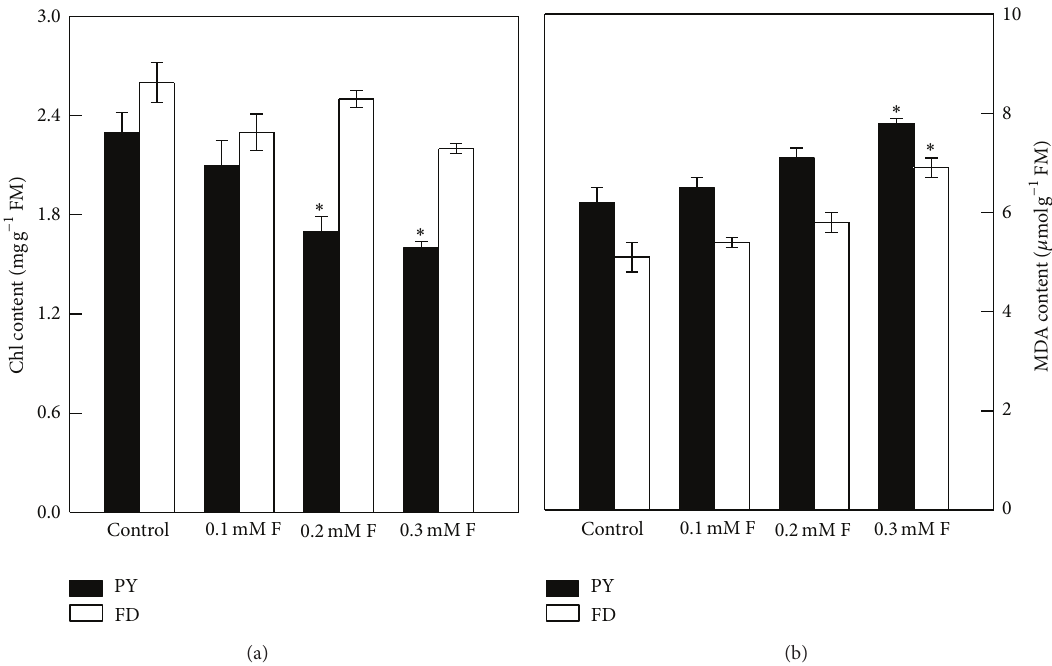
Figure 2: (a) Chlorophyll (Chl) content and (b) malondialdehyde (MDA) content in leaves of PY and FD seedlings after 2 weeks of treatment. Data are expressed as mean ± SD ( 𝑛 = 4 ). PY: “Pingyangtezao” tea cultivar; FD: “Fudingdabai” tea cultivar. ∗ indicates significant difference compared with the control here at 𝑃 < 0.05 according to Fisher’s 𝐹